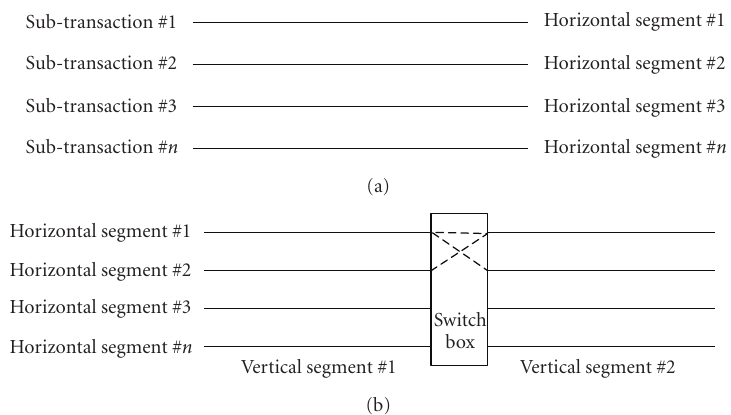
Figure 4: (a) Monolithic shared-bus with horizontal segments for sub-transactions; (b) shared-bus with horizontal segments and a vertical split with a switch box inserted among the vertical